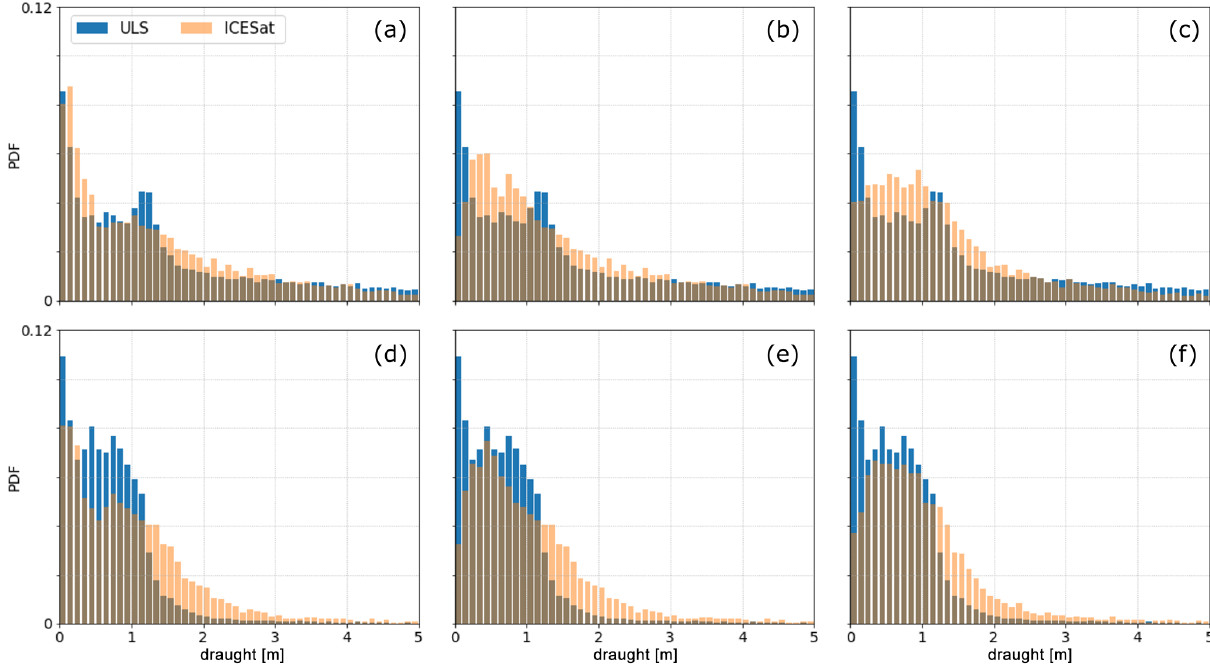
Figure 11. Mean sea ice draught distribution from ULS and ICESat measurements. (a–c) Western Davis Strait; (d–f) eastern Davis Strait. (a,d) PMW snow depth, (b,e) PMW snow depth with sigmoidal redistribution, and (c,f) PMW snow depth with piecewise redistribution. All figures show SnowModel-LG snow